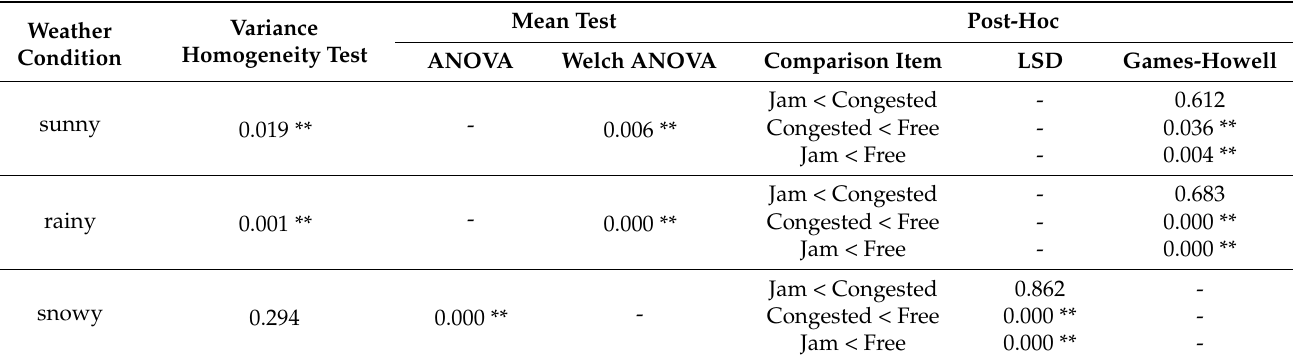
Table 11. The significance test of the effect of traffic flow on the standard deviation of lateral offset.